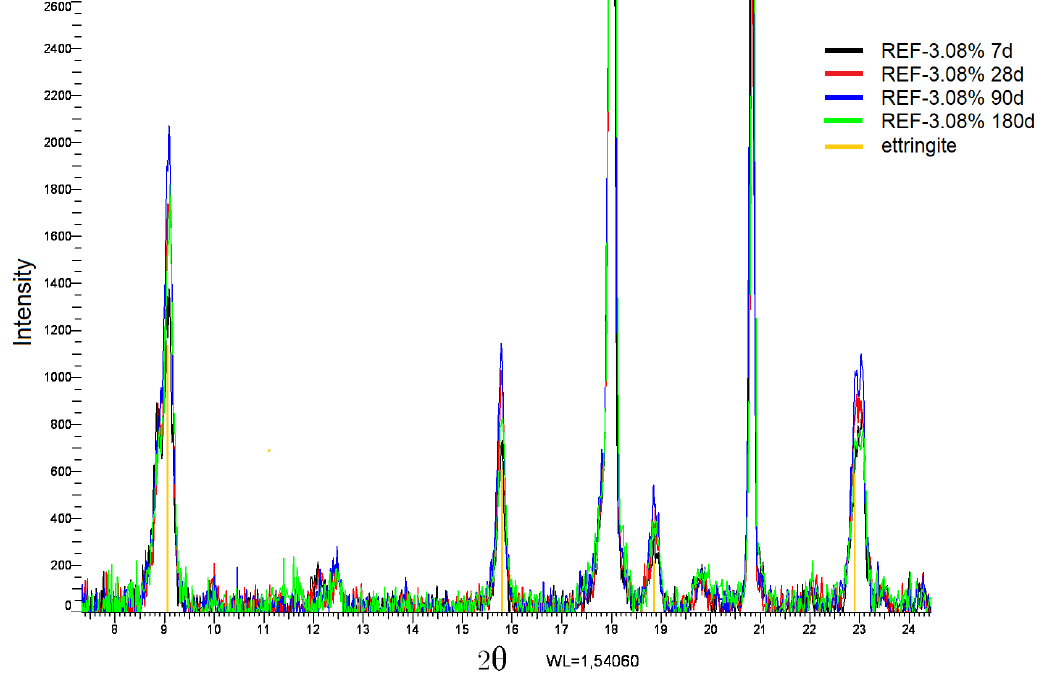
Figure 4. XRD analysis of “REF-3.08%” at 7, 28, 90, and 180